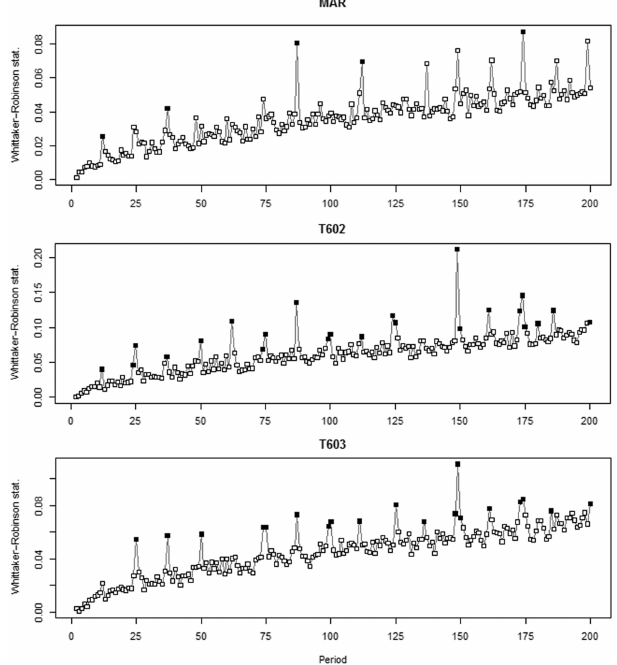
Figure 10. Periodogram analyses of ∼ 9 months of hourly tempera- ture measurements for MAR and NEP (T602 and T603) represented as a 1-week period (equalling 200h). One period is equal to 1h. Black squares indicate periods significant at the 5%